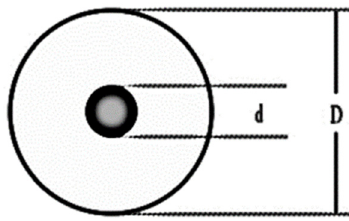
Figure 3. Side view of the structure of the cylindrical ion collection device (d = 5 mm, D = 20